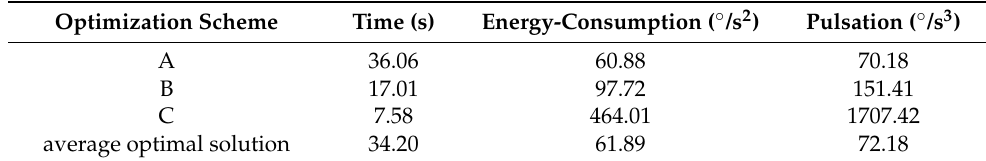
Figure 10. Pareto frontier for trajectory optimization of the manipulator. Table 8. Performance indicators of optimization schemes.